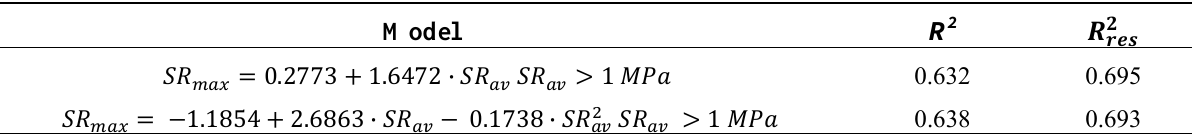
Table 4. Regression analysis between average and maximum soil